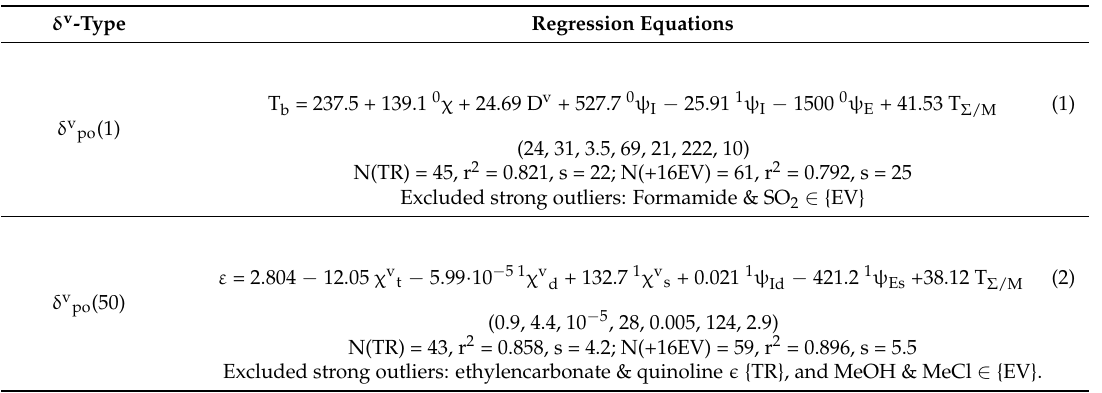
Table 4. Best set of descriptors for the properties of Table 1 with the multilinear least-squares (MLS) methodology. 1st column: δ v type for the valence-dependent indices. 2nd column: set of descriptors and their statistical